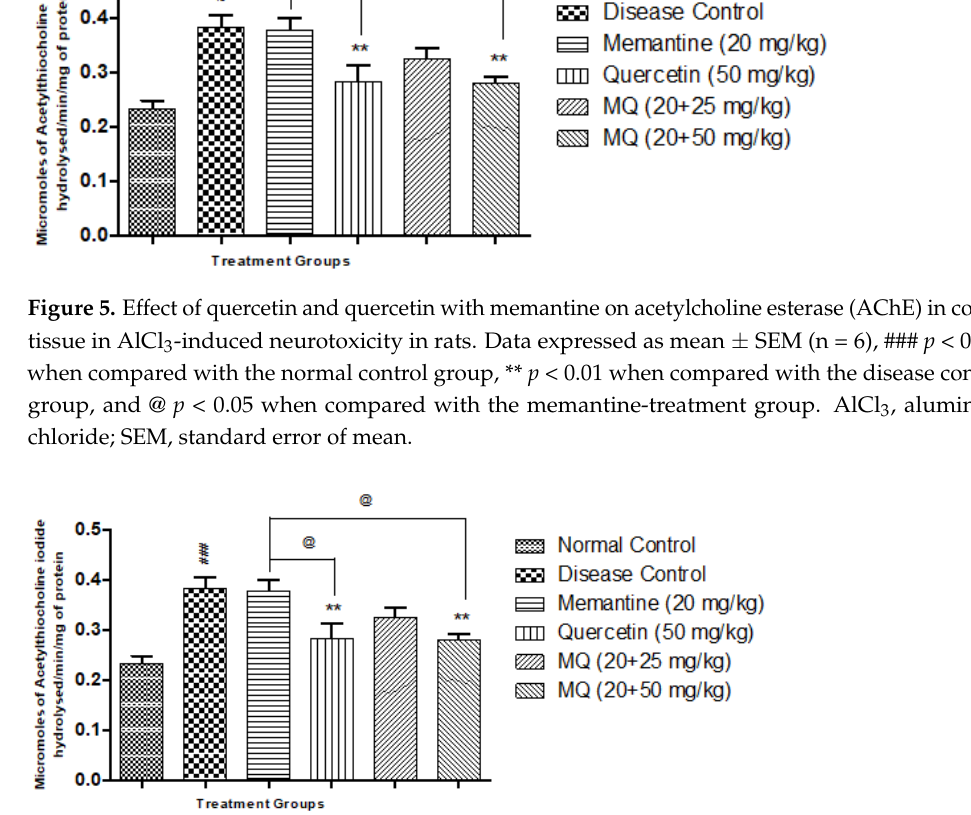
Figure 6. Effect of quercetin and quercetin with memantine on acetylcholine esterase (AChE) in hippocampus tissue in AlCl 3 -induced neurotoxicity in rats. Data are expressed as mean ± SEM (n = 6), ### p < 0.001 when compared with normal control, ** p < 0.01 when compared with the disease control group, and @ p < 0.05 when compared with the memantine-treatment group. AlCl 3 , aluminum chloride; SEM, standard error of mean.